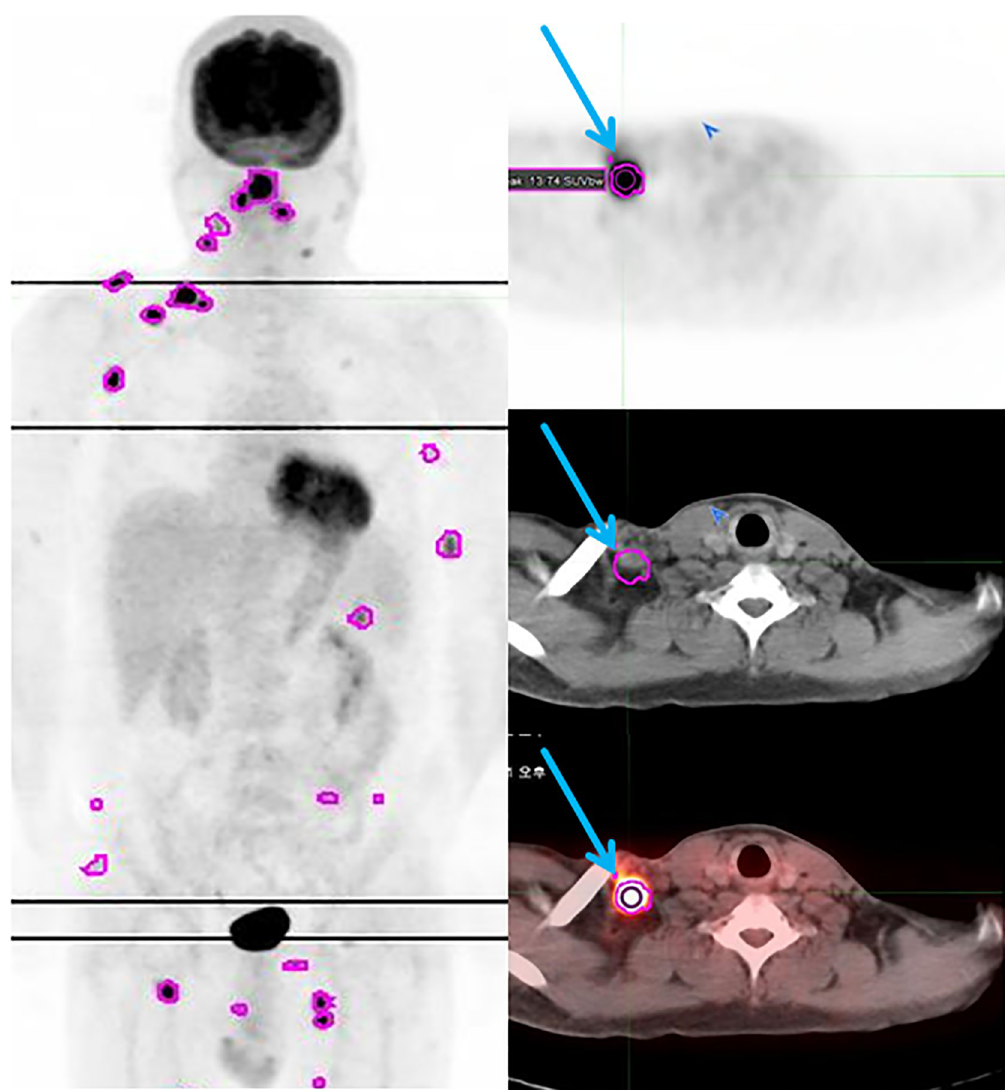
Fig 4. Lower maximum standardized uptake values (SUVmax) and poor prognosis after radioimmunotherapy (RIT) in a 45-year-old male patient diagnosed with diffuse large B-cell lymphoma (DLBCL). The patient was at stage 4 with eastern cooperative oncology group (ECOG) performance status of 1, two extranodal involvement, and an intermediate risk of International prognostic index (IPI) score. 18 F-FDG PET/CT showed disseminated hypermetabolic lymph nodes in tonsil, both submandibular, right supraclavicular, both axilla, both inguinal, both arm, and spleen. The largest tumor size was 2.2 cm. The highest SUVmax was 16.9 in the right supraclavicular LN. Metabolic tumor volume (MTV), and total lesion glycolysis (TLG) were 39.82 and 257.83, respectively. The patient experienced recurrence at 31 months after RIT.